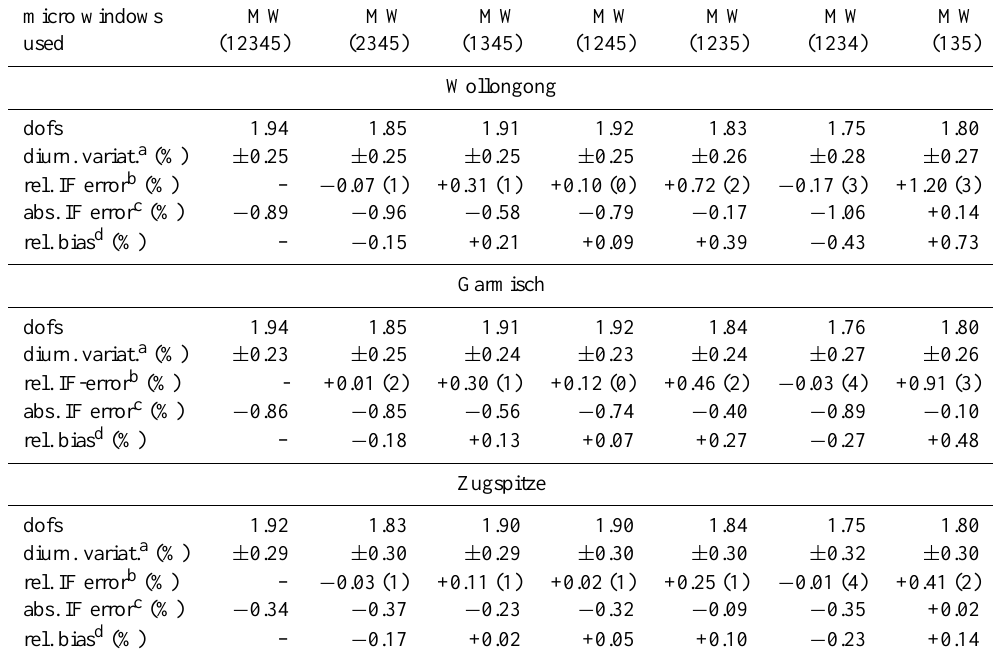
Table 4. Effect of dropping individual micro windows using data from 3 test sites with strongly differing humidity levels; impact on information content (dofs), interference errors, and diurnal variation. The HITRAN 2000 line parameters compilation was